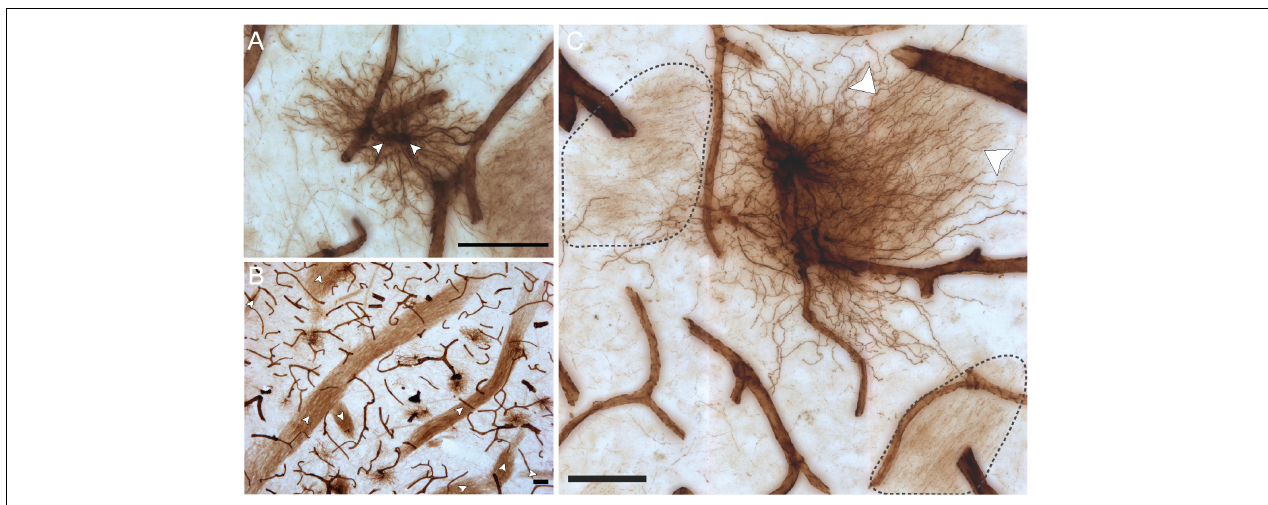
FIGURE 4 | VIM-IR astrocytes display diverse morphological features. (A) Two adjacent VIM-IR astrocyte cell somas (arrowheads) displaying a twin cell morphology were commonly observed in all human brain regions examined. (B) In the caudate nucleus, we observed long bundles of parallel VIM-IR fibers (arrowheads) of no immediately discernable cell origin or target, but which often received contacts from neighboring VIM-IR astrocytes. (C) Some VIM-IR astrocytes extended parallel projections (arrowheads) which may be the origin of the fiber bundles illustrated in (C) and which appear (black outline) from outside of the z -plane of the section, suggesting that VIM-IR astrocytes contact distal targets. Scale bars = 50 µ m.